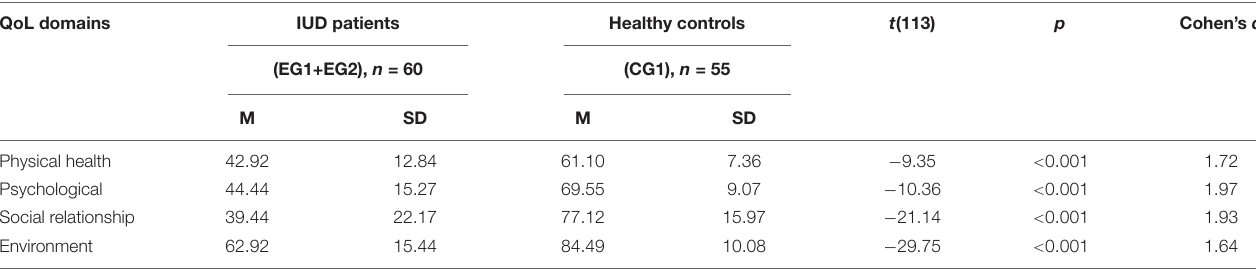
TABLE 2 | QoL domains: IUD patients vs. healthy controls.